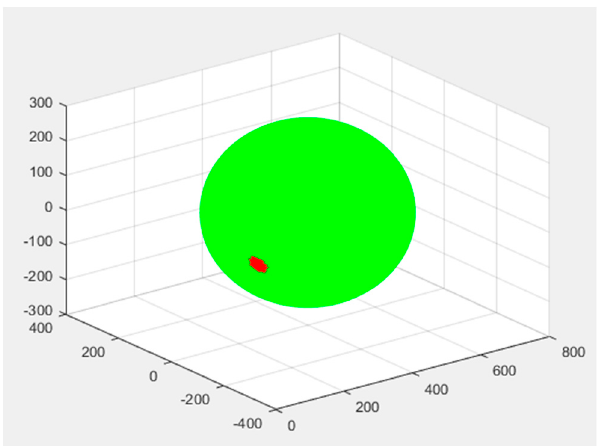
Figure 2. Critical convergence sphere: Surface points in green are good initial position estimates that make the successive approximation method converge at the solution in the center. Points in red fail to make the approximation method converge. This figure displays the first appearance of such instabilities when increasing the radius of the sphere from zero to a critical value marked by the appearance of these defective seeds. The axes represent the 3D environment around the solutions and their units are adimensional due to the illustrative purpose of the figure.